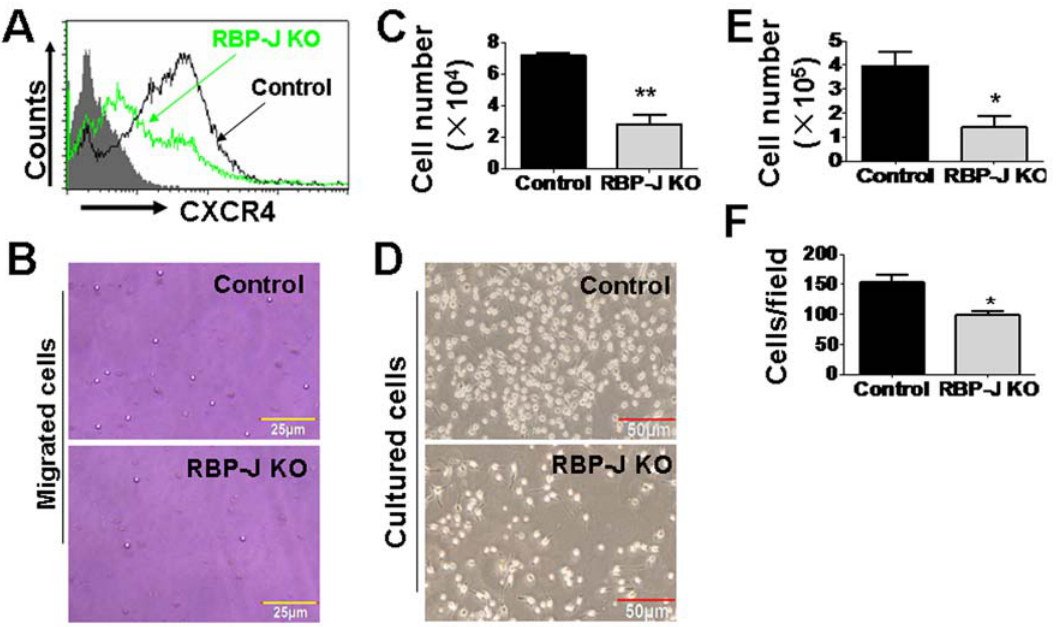
Figure 5. Effect of the RBP-J deletion on the in vitro cultured EPC. ( A ) The expression of CXCR4 on the cultured EPC was accessed by FACS analysis. ( B, C ) In vitro migration assay. Transwell culture was set up, with EPC from the RBP-J-deleted and the control mice in the upper chamber, and SDF-1 a in the lower chamber. A photograph of EPC in the lower chamber ( B ) was taken, and cells in the lower chamber ( C ) were counted 18 h after the starting of the culture (bars=mean 6 SD; n=4; ** P , 0.01). ( D ) The formation of colonies by the cultured RBP-J knockout and the control EPC. ( E ) The number of total EPC formed 7 days after the culture. ( F ) The number of EPC attached on the gelatin-coated dishes 3 days after the culture. (bars=mean 6 SD; n=4; * P , 0.05).